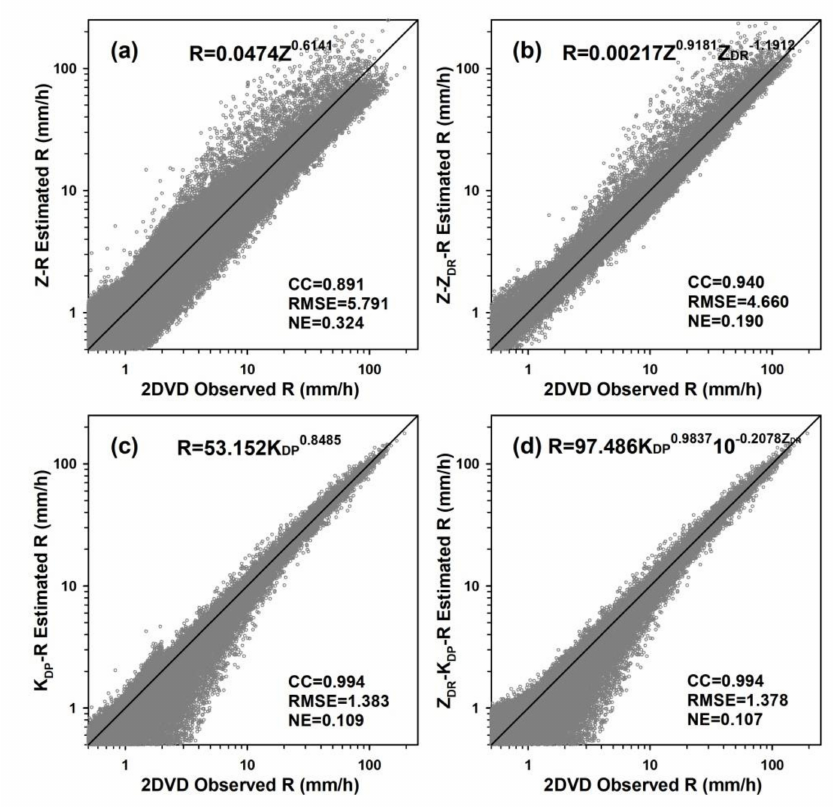
Figure 2. Scatterplot of rain rate retrieved from ( a ) R(Z H ), ( b ) R(Z H , Z DR ), ( c ) R(K DP ), and ( d ) R(K DP , Z DR ) vs. the directly observed rain rate from the 2DVDs during summer monsoon periods from 2017 to